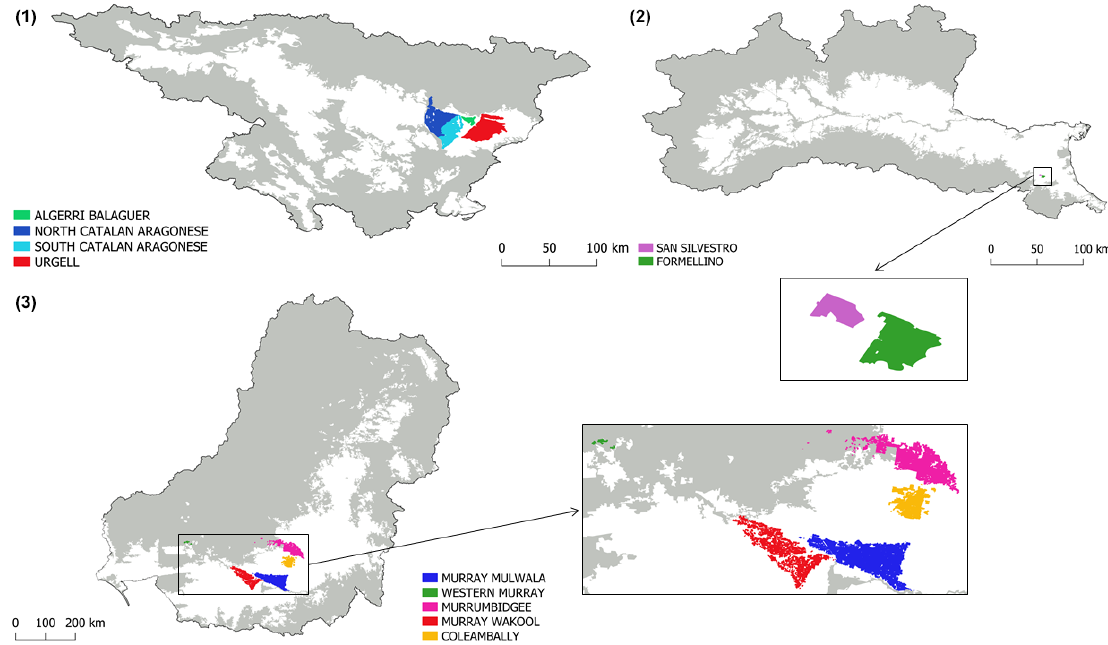
Figure 3. Pilot irrigation districts whose irrigation data have been used for calibration and validation purposes: (1) the Ebro basin, (2) the Po valley, and (3) the Murray–Darling basin. For each region, the agricultural areas over which the irrigation estimates have been carried out are indicated in white. Table 1. Summary of the collected ground-truth irrigation